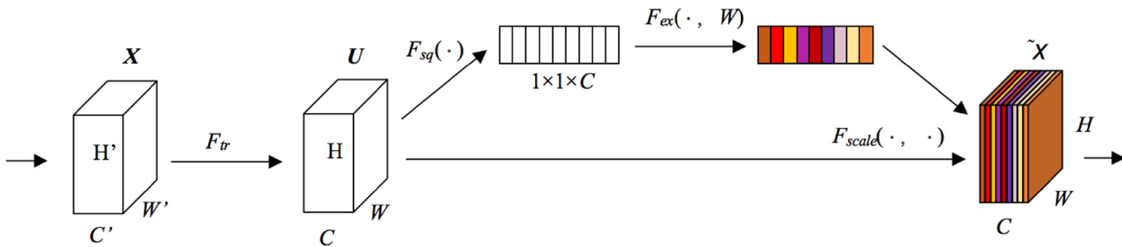
Figure 7. The three steps for SE operation.